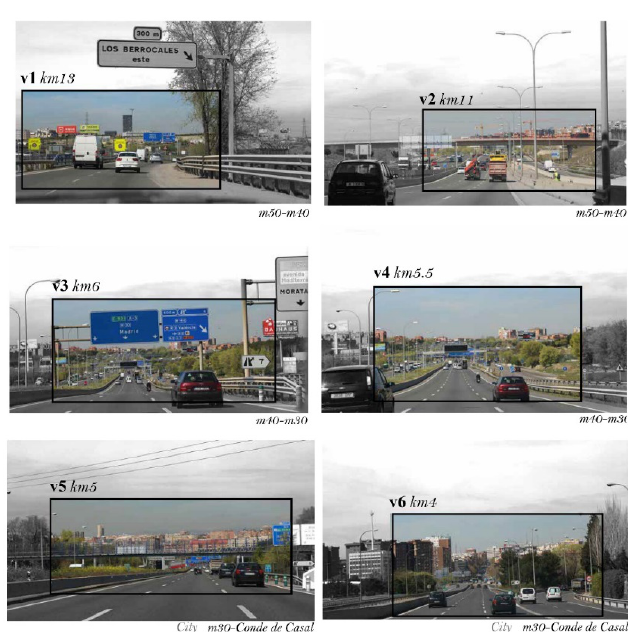
Figure 7: Selection of frames throughout the studied section of the A3 main access